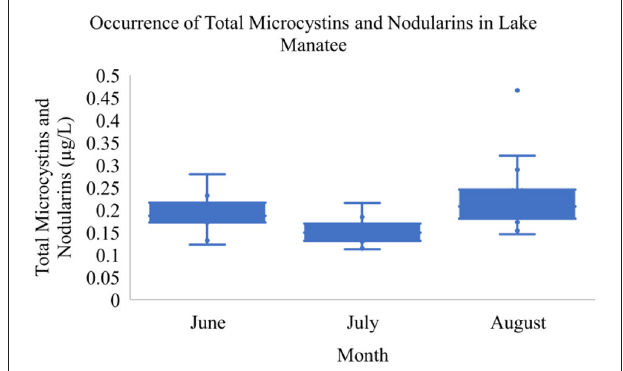
FIGURE 2 | Occurrence of total microcystins and nodularins in Lake Manatee. TABLE 1 | Pairwise comparisons of sampling sites and toxin concentrations. Site comparisons